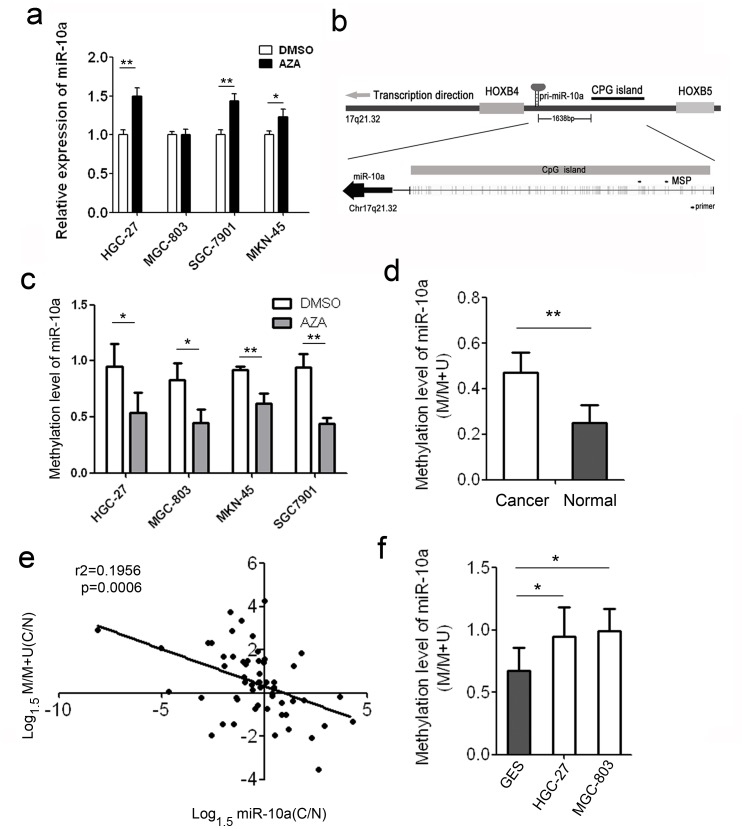
miR-10a is epigenetically silenced in GC cell lines and GC patients.
a Validation of the expression of miR-10a in HGC-27, MGC-803, SGC-7901 and MKN-45 cell lines treated with 5-AZA. b The genomic structure of miR-10a and its surrounding region. The CpG island is located at 1.6 kb upstream of miR-10a. Vertical ticks represent CpG sites. c qMSP analysis of the methylation level of the miR-10a genomic region in GC cell lines and after 5-AZA treatment. d The methylation level of the miR-10a genomic region in GC tissues (cancer) was higher than their matched adjacent non-neoplastic tissues (normal) in 55 GC patients. e The inverse correlation between miR-10a expression and the methylation status of the miR-10a genomic region in the investigated 55 GC patients. f The methylation level of the miR-10a genomic region in GES, HGC-27 and MGC-803 cells. All data are presented as the means ± SD. *, P<0.05; **, P<0.01, ***, P<0.001.